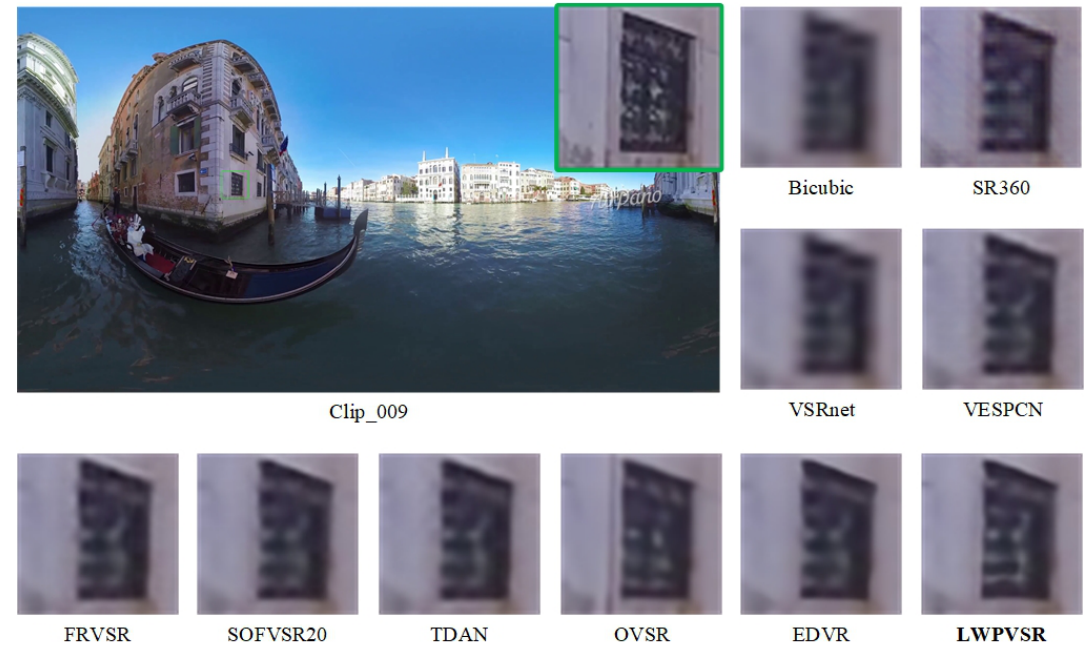
Figure 10. The results of all the algorithms performing 4 × super-resolution on Clip_009 of the MiG test set.